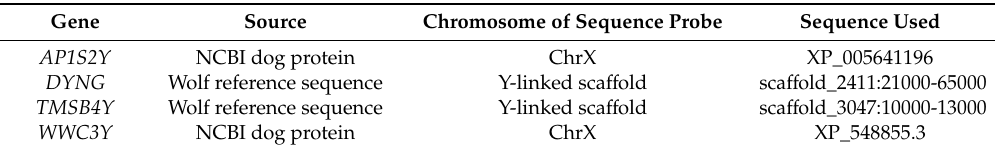
Table 2. Wolf MSY genes compared to the red fox genome. When dog X-chromosomal protein sequences were available, they were compared to the red fox draft genome using translated BLAST (tblastn). In the remaining cases, the sequences of the regions of the wolf reference genome [42] that contained the MSY genes [14] were compared to the draft red fox genome using standard nucleotide BLAST (blastn). Other than DYNG , which was initially reported in dogs [6], these genes have not been identified on the Y-chromosome of dogs or cats. NCBI refers to the databases maintained by the National Center for Biotechnology Information. Gene Source Chromosome of Sequence Probe Sequence